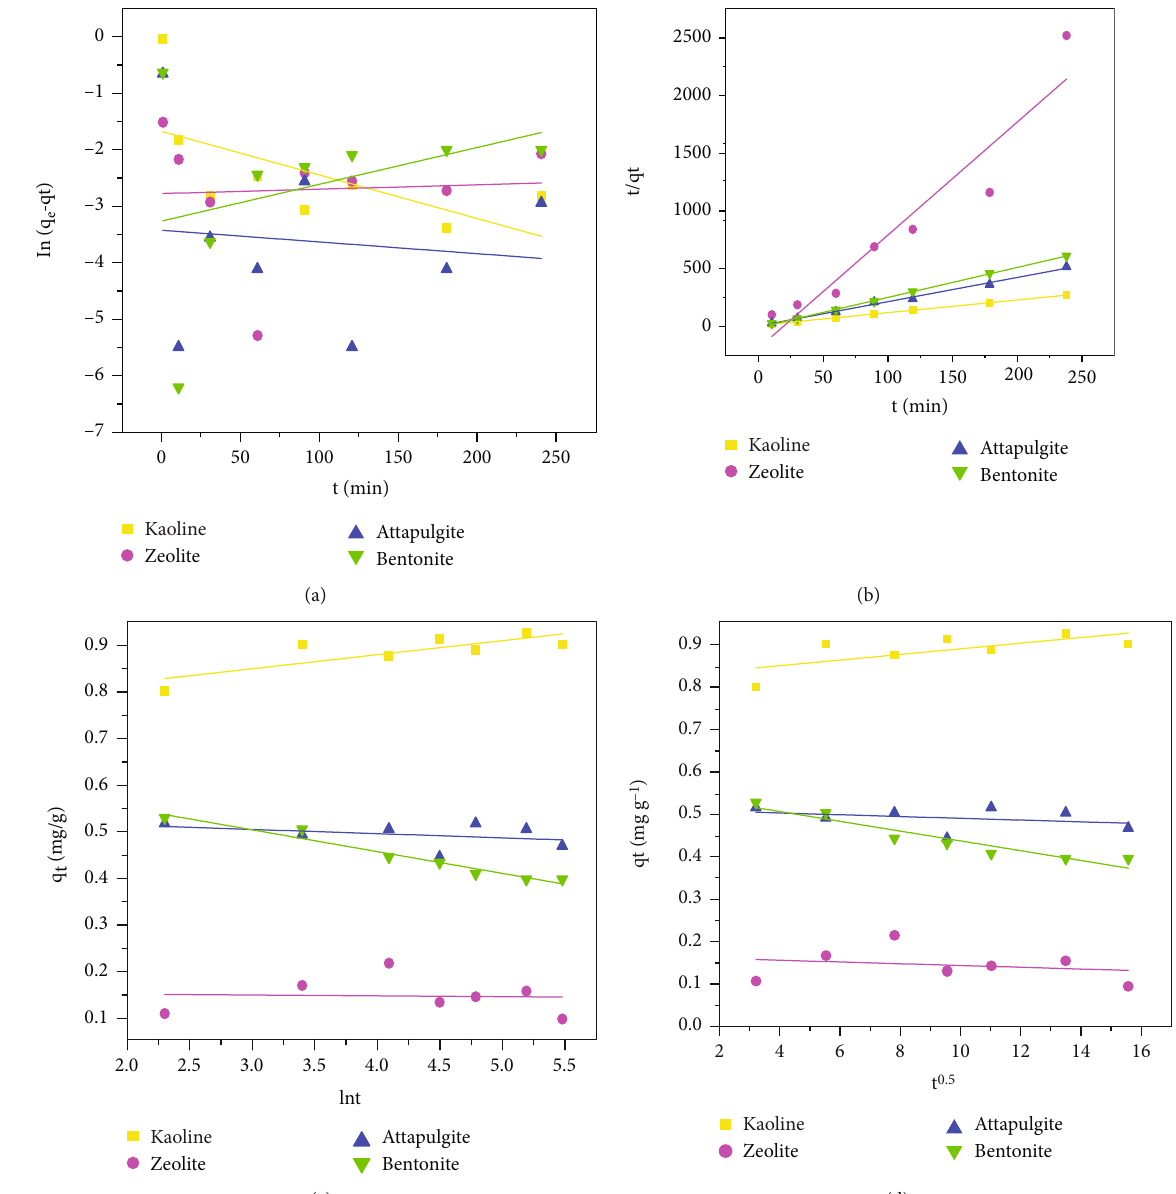
Figure 6: Four linear kinetic models for the adsorption of ammonia nitrogen on NCMs. (a) Pseudo- fi rst-order kinetic model. (b) Pseudo- second-order kinetic model. (c) Elovich model. (d) Intraparticle di ff usion model. C